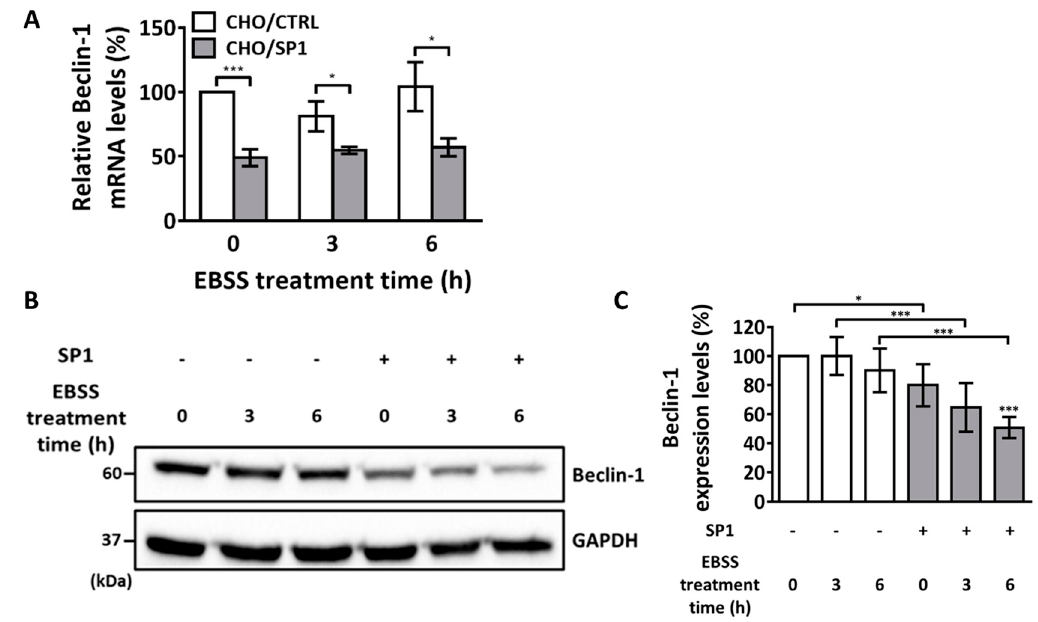
Figure 5. The mRNA and protein levels of Beclin-1 after the EBSS treatment. ( A ) Quantitative PCR analysis of Beclin-1 mRNA levels in the CHO/CTRL and CHO/SP1 cells treated with EBSS for 0, 12, and 18 h. ( B ) Western blotting analysis of Beclin-1 protein levels in the CHO cells treated with EBSS for 0, 4, and 10 h. GAPDH was used as an internal control. ( C ) Quantitative analysis of the results of Western blotting analysis shown in ( B ) for Beclin-1 levels normalized using the GAPDH levels. Statistical analysis of data obtained from three independent experiments was performed using GraphPad Prism 7.0 software and ImageJ 1.43. All values are represented as mean ± SD (* p < 0.05, ** p < 0.01, and *** p < 0.001; n = 3).